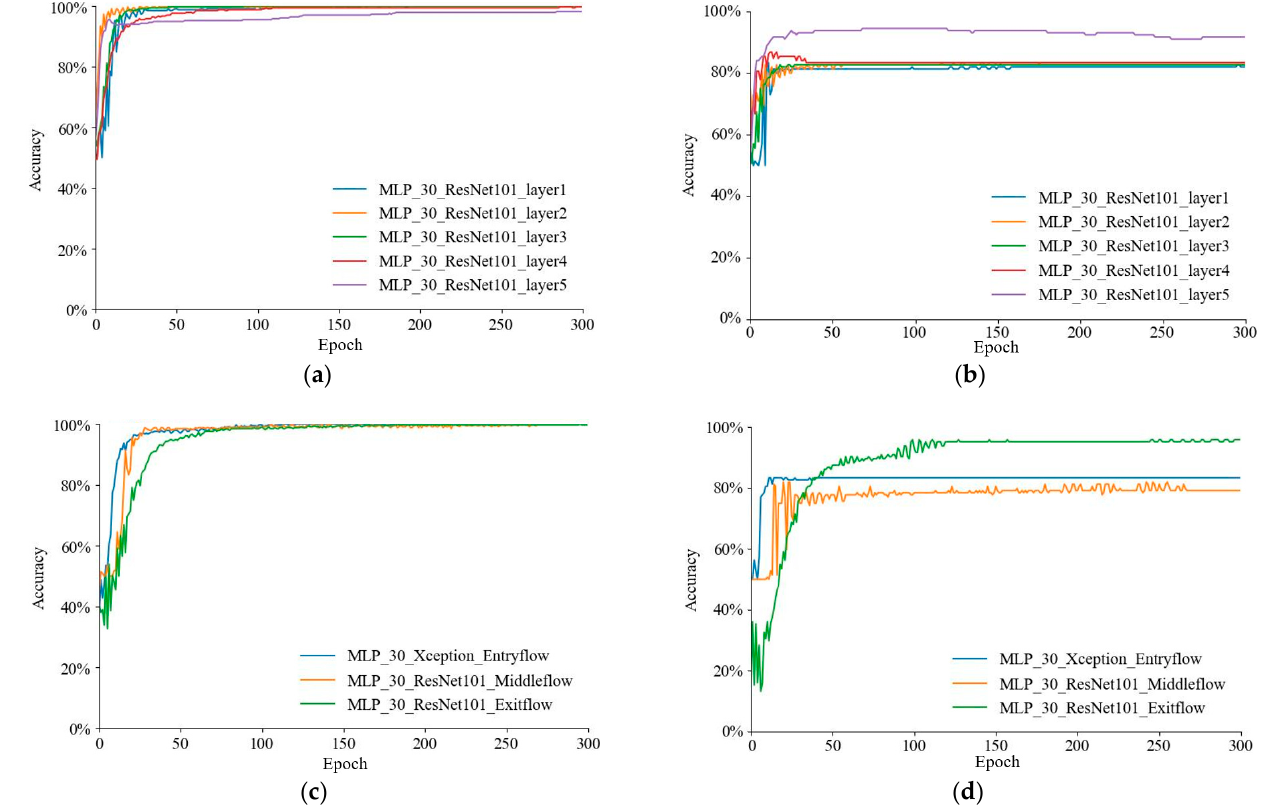
Figure 10. Results of different layer fusion modeling of convolutional neural networks: ( a ) training accuracy curves for five different layers of ResNet101; ( b ) validation accuracy curves for five different layers of ResNet101; ( c ) training accuracy curves for three different layer fusion modeling of Xception; and ( d ) validation accuracy curves for modeling of three different layer fusions of Xception.